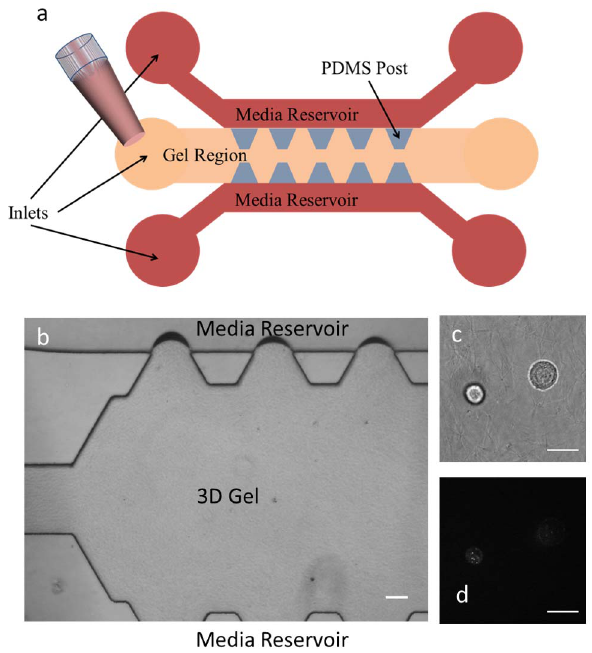
Figure 1. Schematic of the microfluidic device for 3D micro- rheology experiments. a) Cells in gel are loaded into the gel region via pipetting. The PDMS posts and surface tension keep the gel localized in the gel region. Media is then added to the media reservoirs via pipetting and allowed to diffuse into the gel region. b) Image of the device with collagen gel loaded into and kept contained in the gel region. The device channel height is 200 m m and the inter-post separation is 330 m m. (c) Bright field and (d) fluorescence images of cells embedded in 3D inside the device with ballistically injected 500 nm- diameter fluorescent nanoparticles. The scale bars are 100 m m in (b) and 20 m m in (c) and (d).